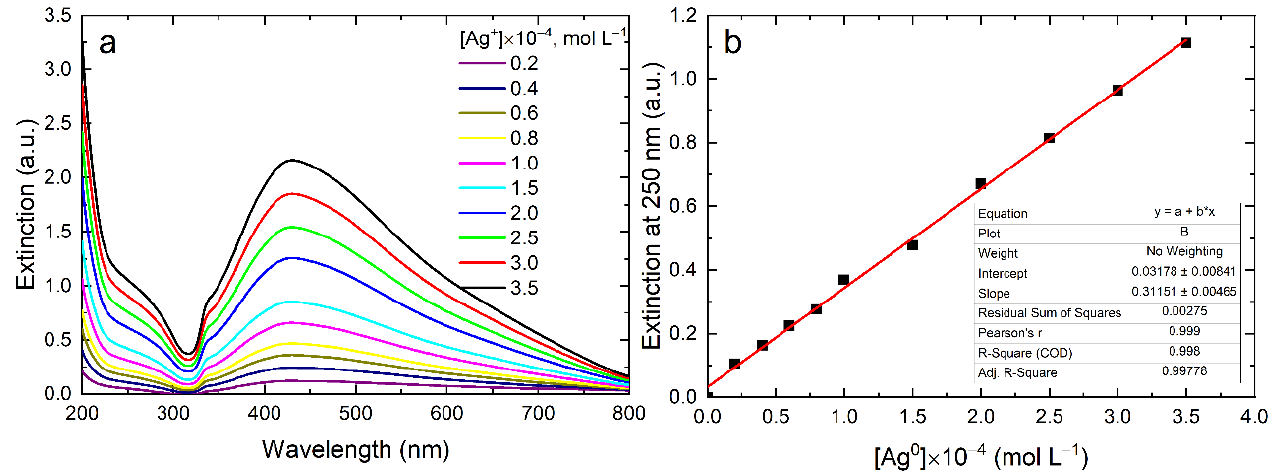
Figure 7. Variation of absorption of the silver hydrosol during its formation by the reduction of Ag + with NaBH 4 in the presence of sodium citrate and hydrogen peroxide ( a ); IBT absorption at 250 nm as a function of Ag 0 concentration ( b ). Solution: Ag + (0.4–3.5) × 10 − 4 mol L − 1 and citrate 1.8 × 10 − 3 mol L − 1 . Optical path length: 10 mm.